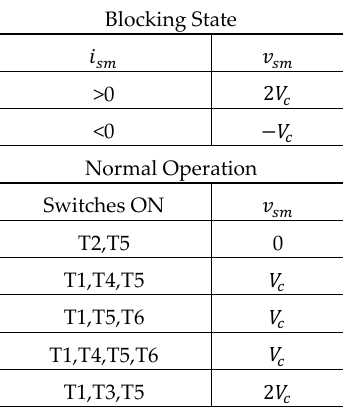
Figure 17. Figure 17. CSM 416